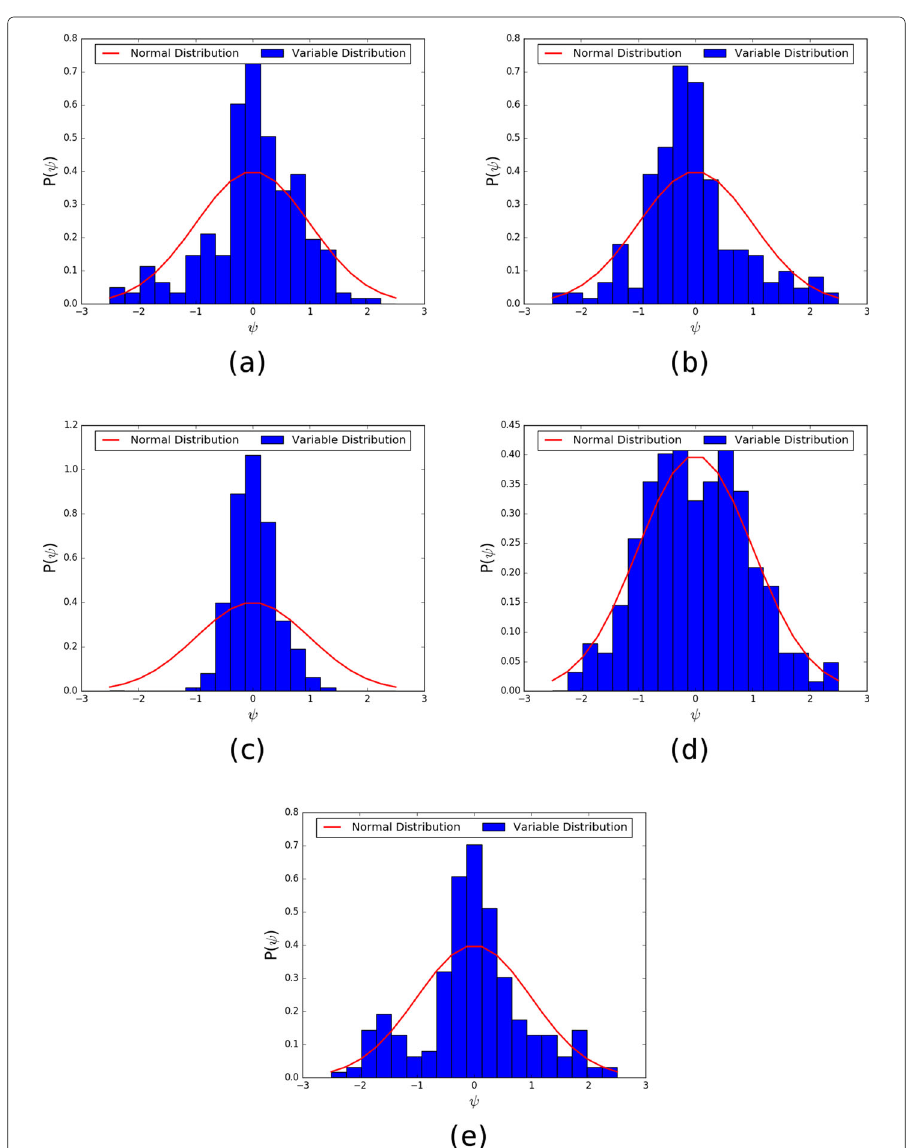
Fig. 10 The distribution of noise variables for ( a ) Bitcoin, ( b ) Ethereum, ( c ) Twitter, ( d ) Reddit, and ( e ) GitHub sampled from 242 days of data collection compared against a normal distribution with mean zero and unit